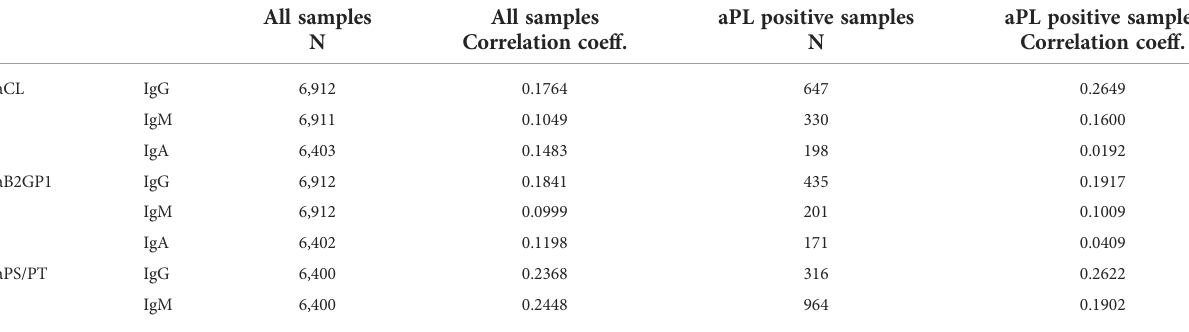
TABLE 3 Correlation between aPL and PC4d.